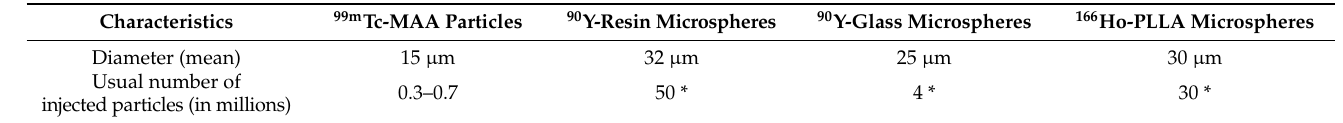
Table 2. Main physical characteristics of MAA and radioactive